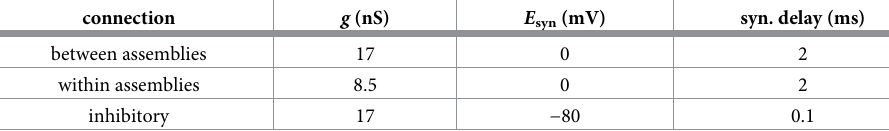
Table 5. Connection parameters for conductance-based stimulus disambiguation experiments. connection g (nS) E syn (mV) syn. delay (ms) between